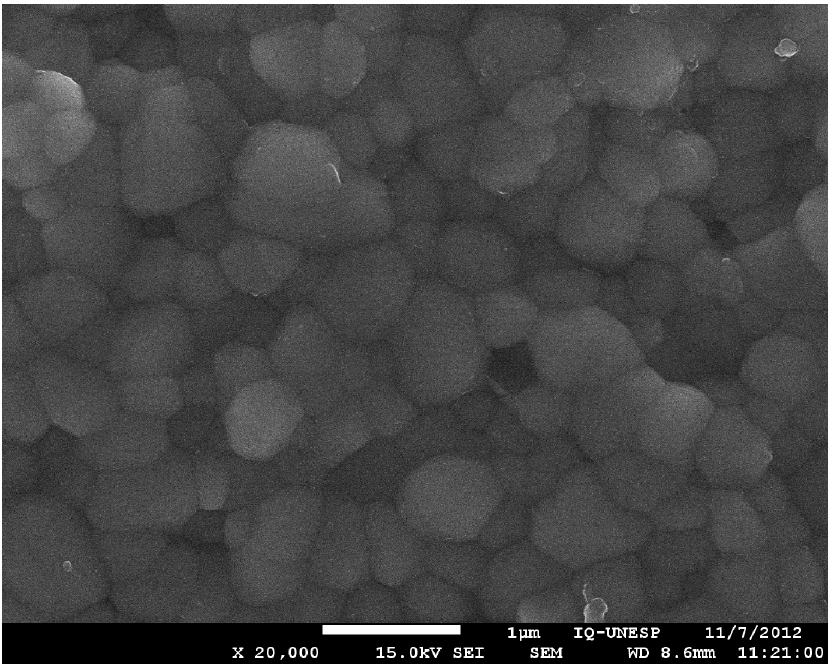
Figure 2. Scanning electron microscopy (magnification 20,000×) of the zirconia